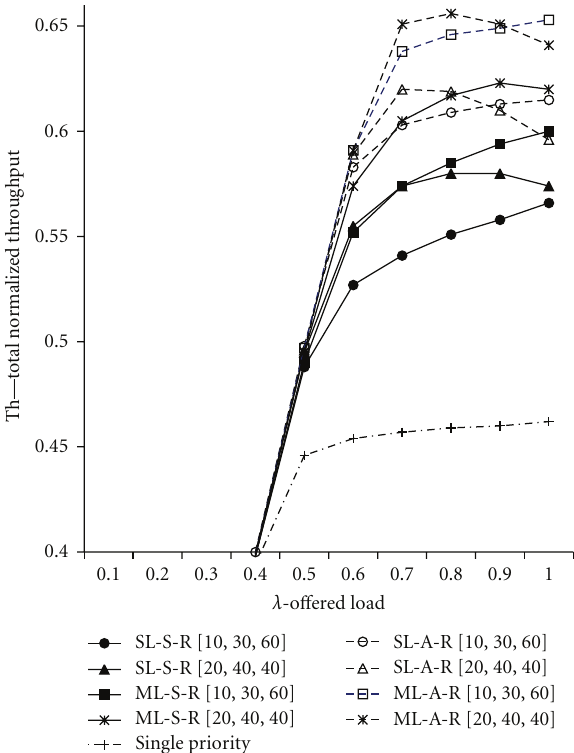
Figure 2: Total normalized throughput versus o ff ered load.